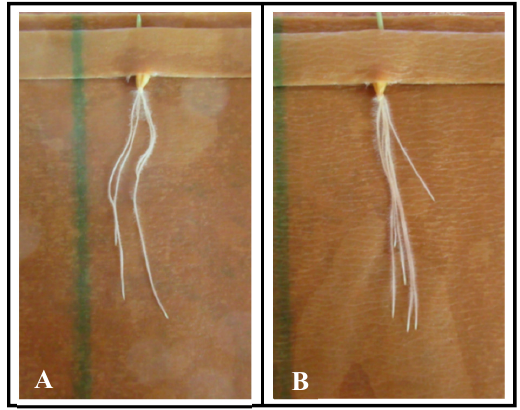
Figure 3. Similar root morphology and growth of “Kopious” ( A ) and “Solar” ( B ) barley roots 4 days after transfer from petri plates to growth pouches.